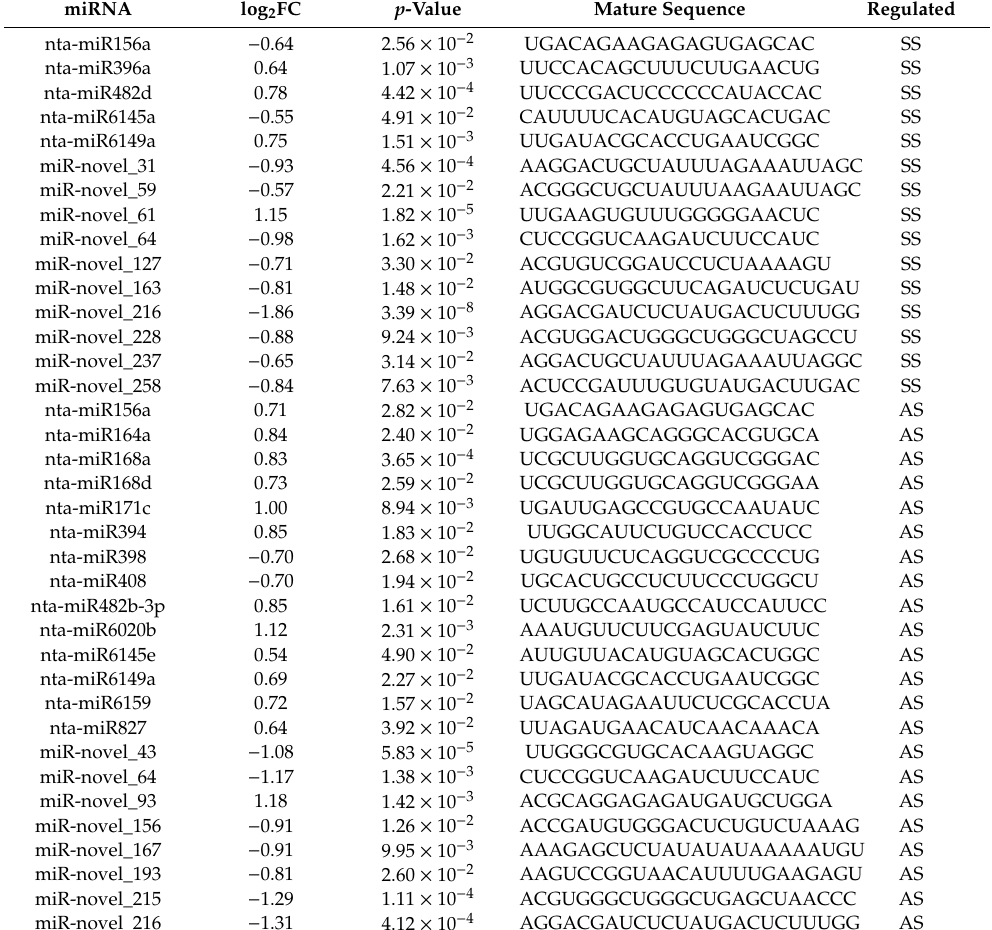
Table 3. List of di ff erentially expressed microRNAs (DE miRNAs) in response to SS and AS treatments.